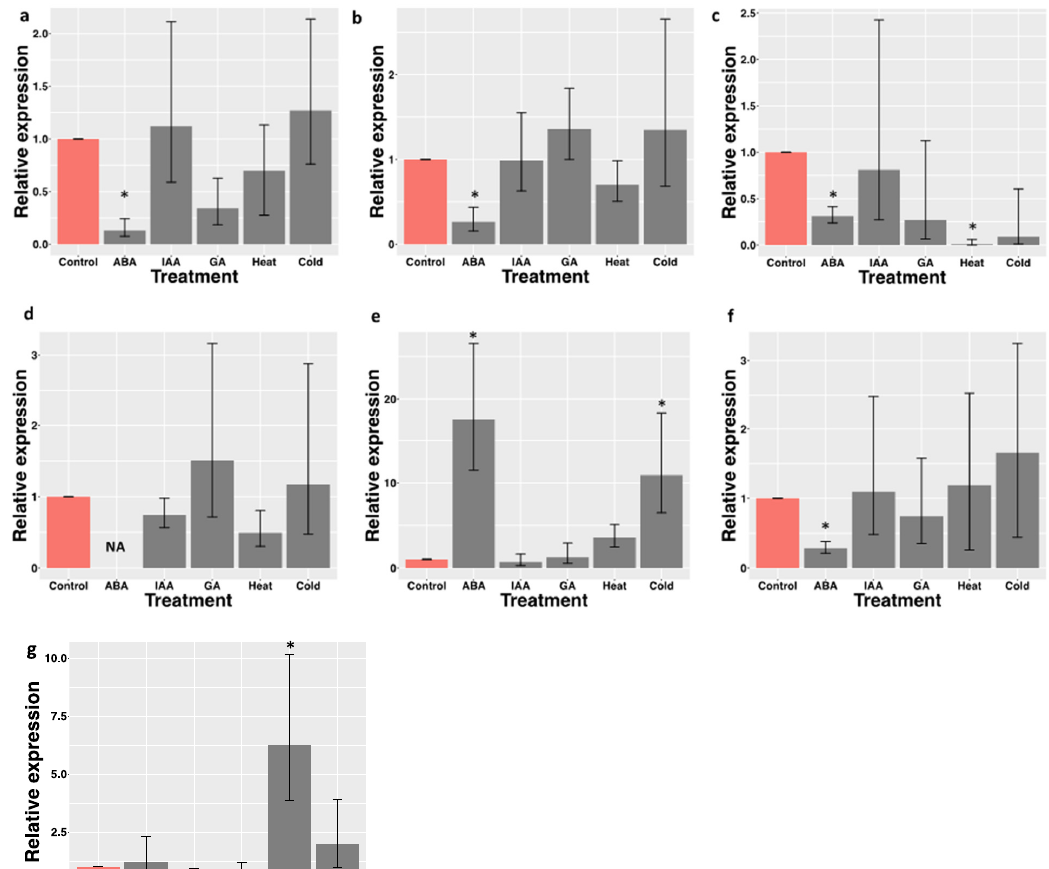
Figure 7. Relative expression analysis of putative terpene biosynthetic genes in S. hispanica leaves exposed to abiotic stress (heat and cold) and hormone treatments. ABA: abscisic acid; IAA: indole acetic acid; GA: gibberellic acid. a) Sh_contig_19087; b) Sh_contig_46958; c) Sh_contig_57906; d) Sh_contig_42579; e) Sh_contig_61221; f) Sh_contig_64857 g) Sh_contig_65227. Error bars represent the standard error of the mean (SEM). Asterisks indicate significant differences ( P < 0.05; Student’s t-test).